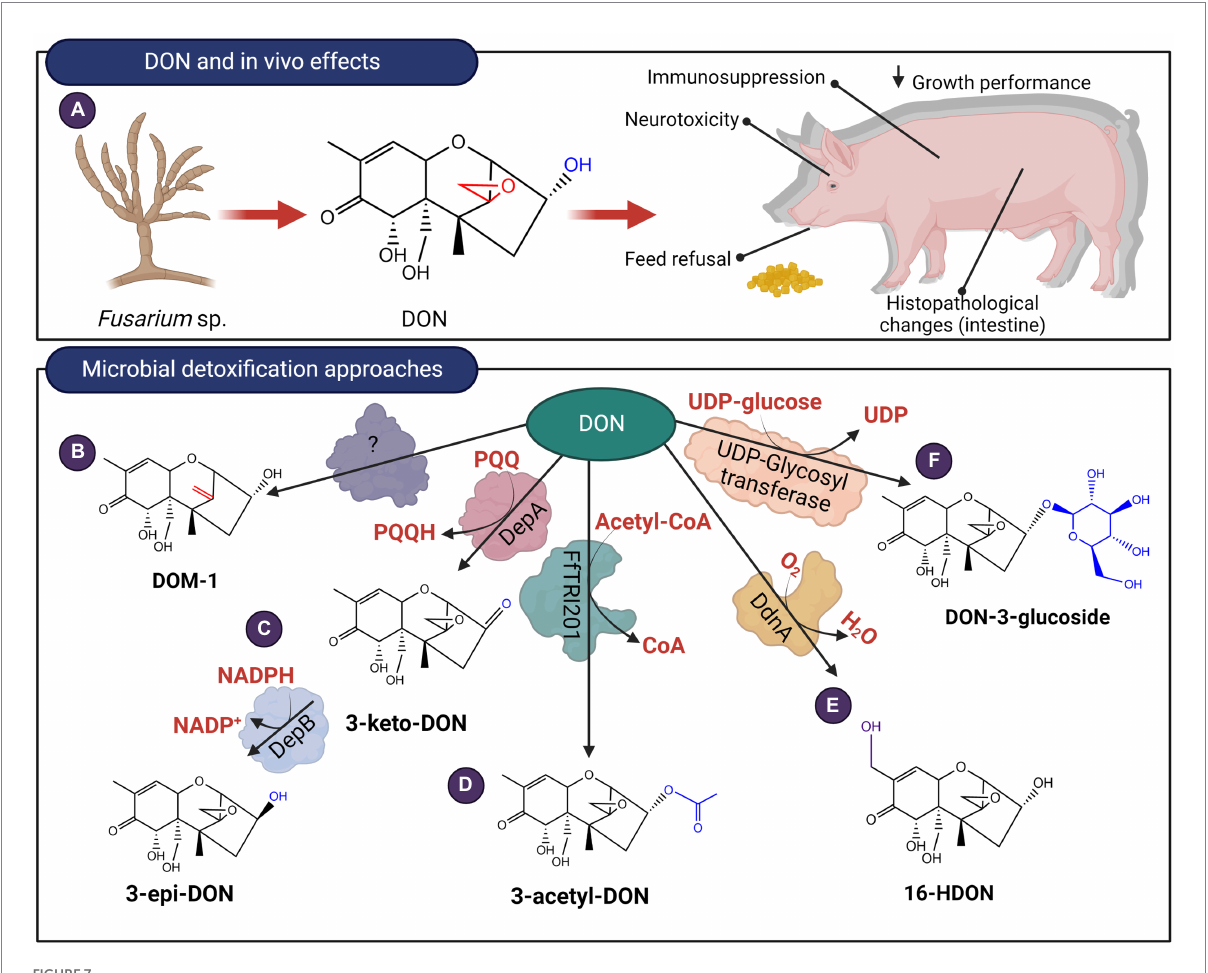
FIGURE 7 In vivo effects of Type B trichothecenes like DON and microbial detoxification approaches. (A) DON affects the gastrointestinal system and at a molecular level, the mycotoxin can bind to ribosomes triggering ribotoxic stress. (B–F) DON can be transformed by de-epoxidation, oxidation, epimerization, acetylation, hydroxylation and